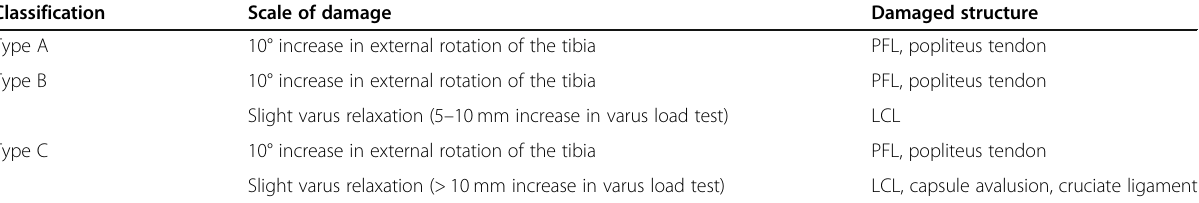
Table 1 The Fanelli and Larson classification: classification of damage in posterolateral structures Classification Scale of damage Damaged structure